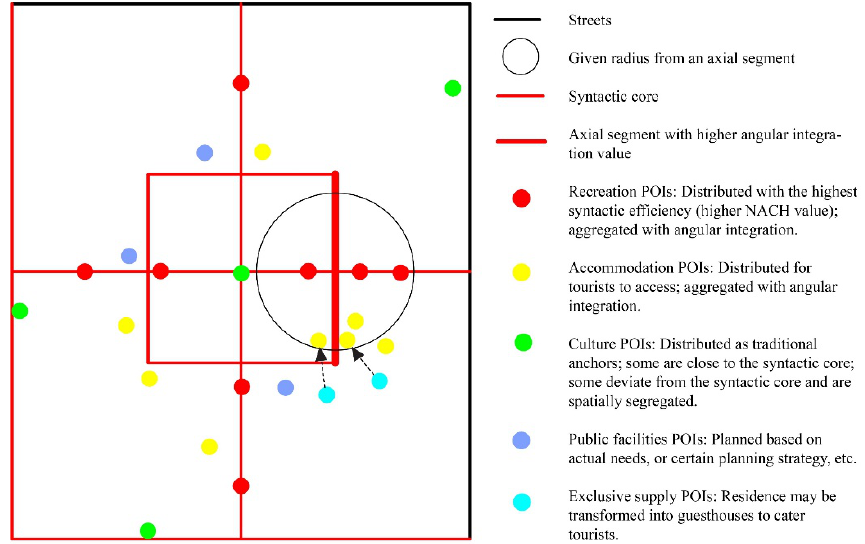
Figure 12. Illustration of the spatio-functional patterns of the five types of POI land use (in a simplified plan of a general HCT).